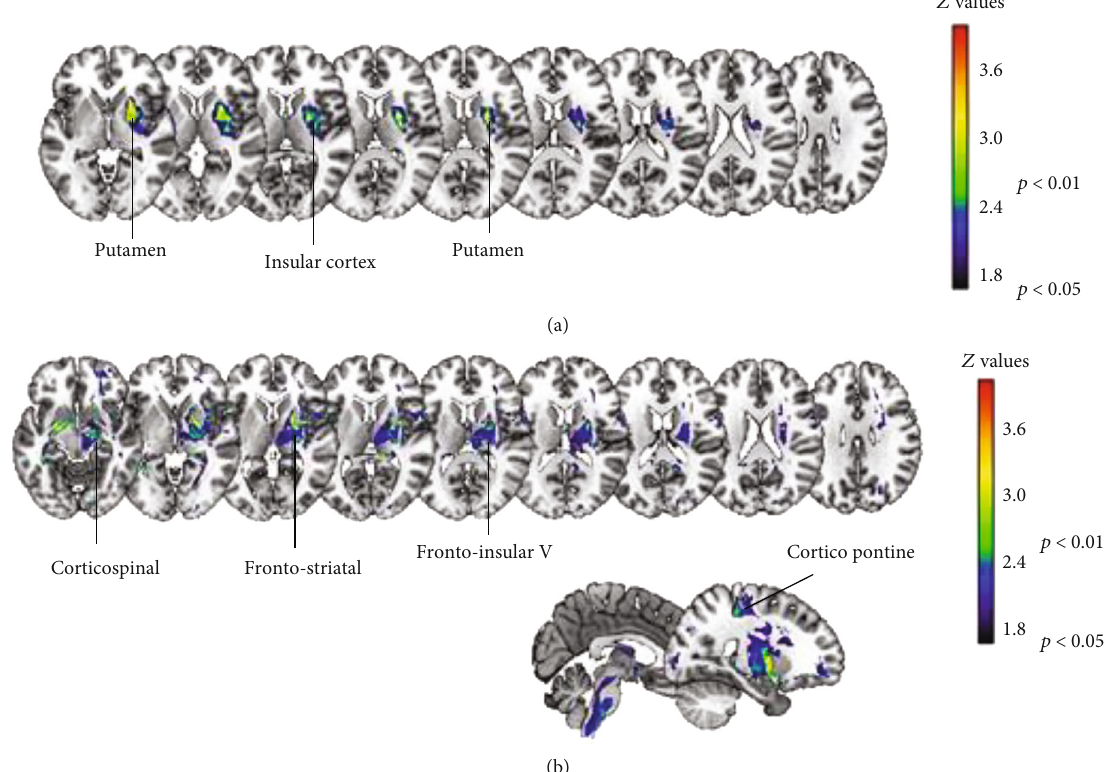
Figure 3: Signi fi cant brain-behavior associations observed between the pretreatment F-M UE scores and lesions (a) or white-matter disconnections (b).